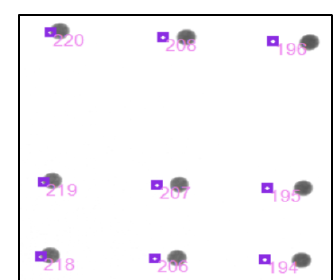
Figure 12. Template targets (in magenta) aligned over their conjugates